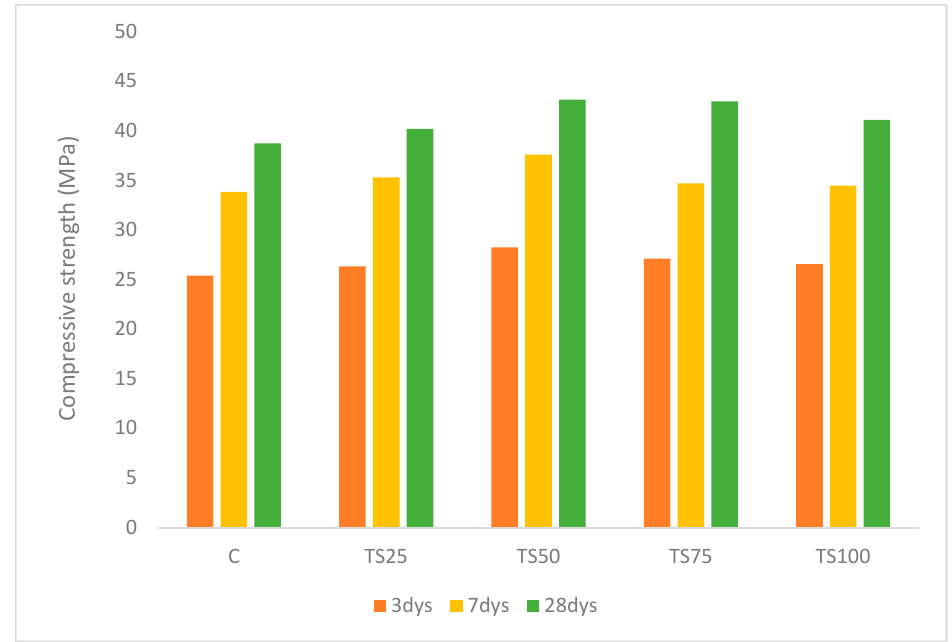
Figure 11. The compressive strength development of graded TS mortars at a w / c of 0.55.